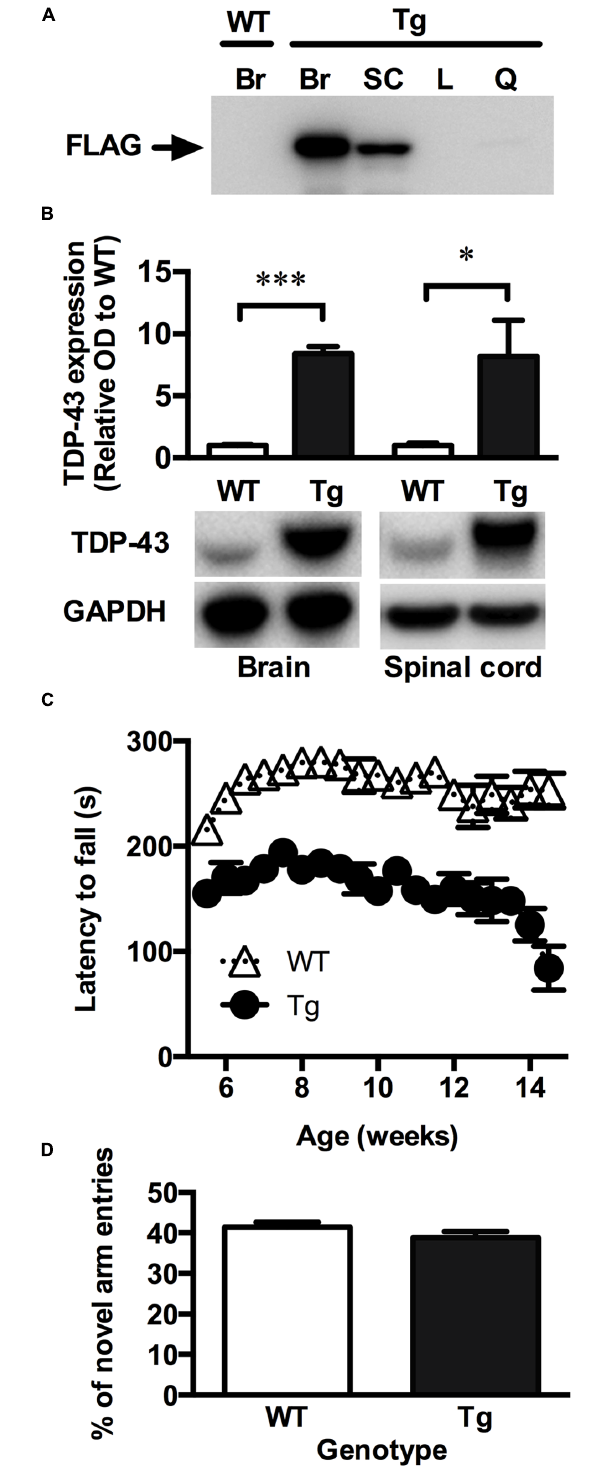
FIGURE 1 |TDP-43 A315T mice express mutantTDP-43 in the CNS and exhibit a locomotor impairment. (A) Representative western blot showing the absence of mutant FLAG-taggedTDP-43 (FLAG) expression